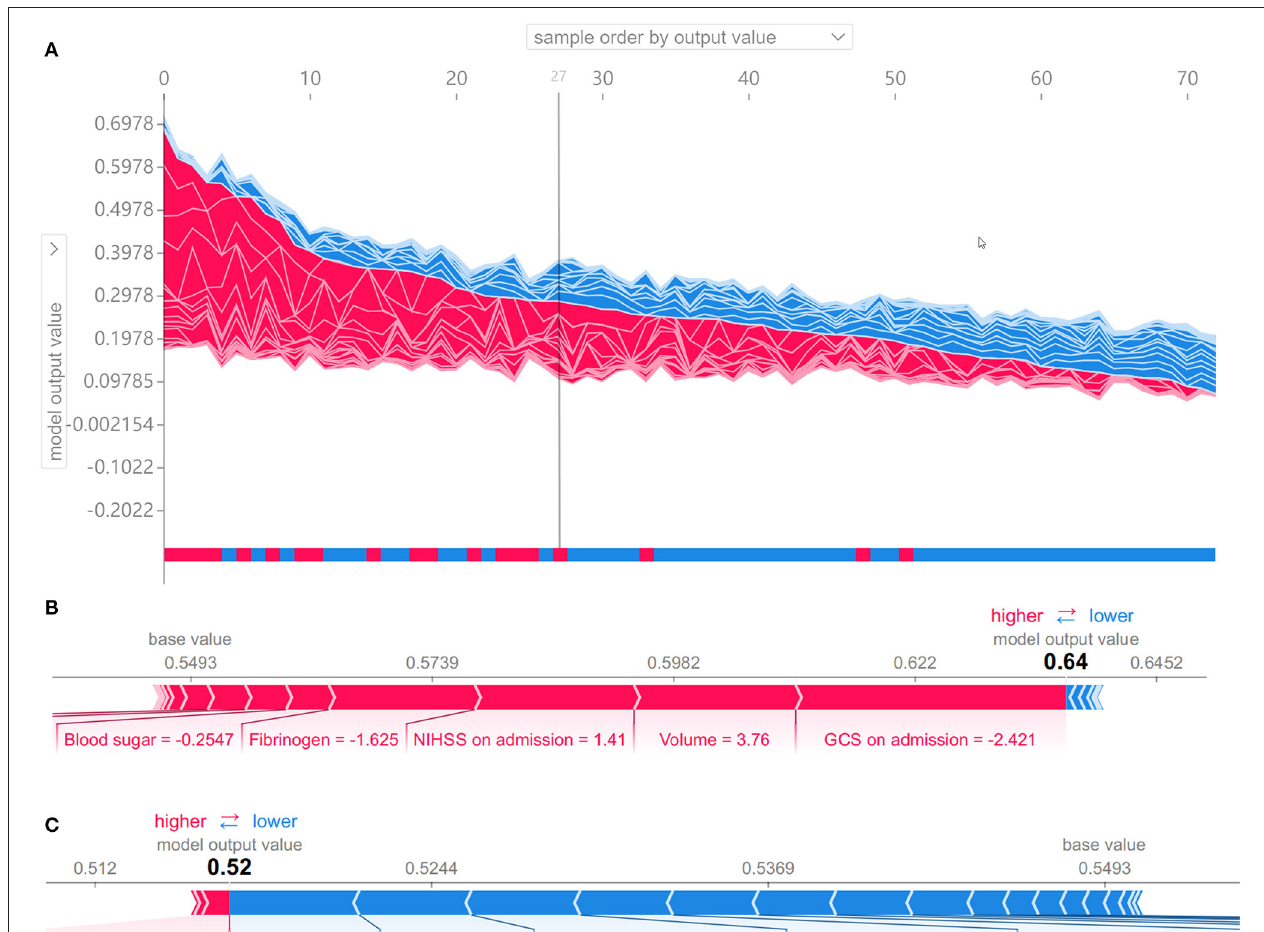
FIGURE 7 | Shapley additive explanation (SHAP) values to show interpretability of the effects of AI-derived volumes and clinical variables as the input risk factors for the prediction of progression to severe stroke. (A) SHAP values for all 73 patients in the test set. Samples from left to right are ordered by the sum of the SHAP values from all variables, and the bottom bar shows the true labels of each sample, namely, red for the positive group (progression to severe stroke) and blue for the negative group (non-progression to severe stroke). The 27 samples on the left are predicted as positive samples by the random forest model. (B, C) SHAP values of two typical patients from the positive group (B) and the negative group (C) , illustrated with their most important